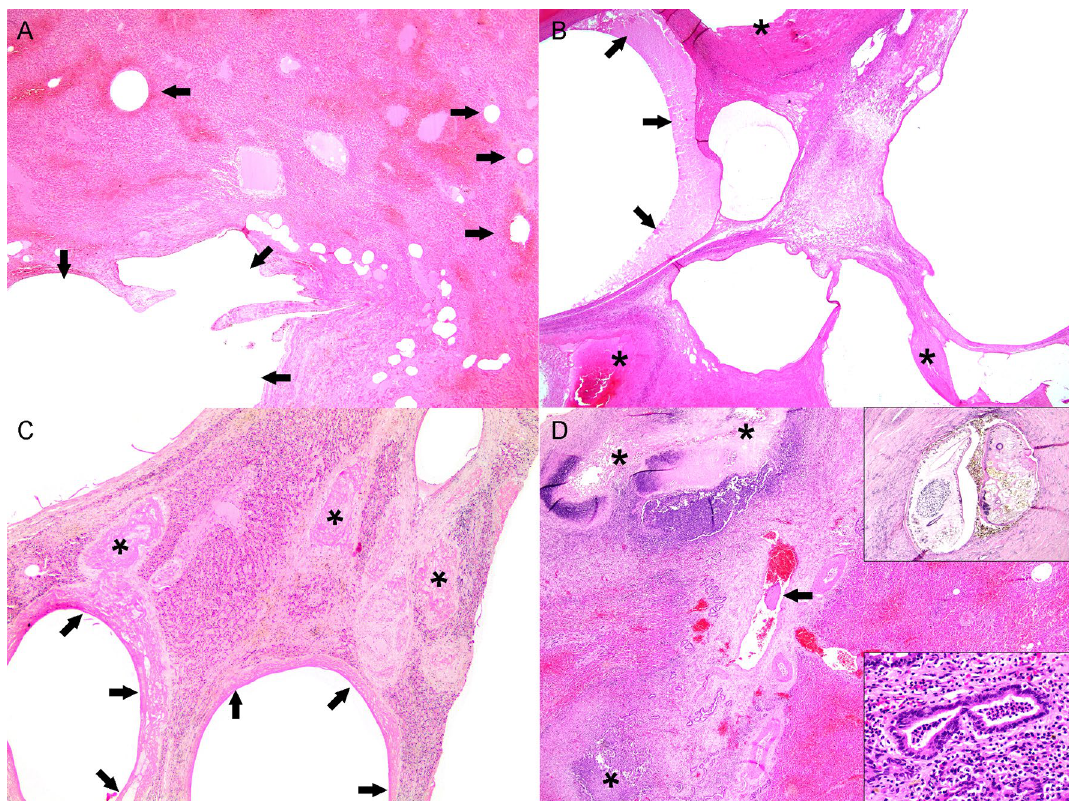
Figure 2. Microscopic features of cystic liver lesions in dolphins. ( A ) Case 4. Acute cystic lesions including cystically dilated veins of varying calibers (arrows) along with hemorrhage and sinusoidal congestion. ( B ) Case 4. Early cystic characterized by negatively-stained (empty, gas-filled) cystic dilatations with serum protein (arrows) and fibrin (asterisks). Remaining hepatic parenchyma exhibits degenerative and atrophic phenomena, as well as hepatocellular loss. ( C ) Case 3. Early to subacute venous cystic dilatations where thick peripheral fibrin (arrows) and thrombi (asterisks) prevail. The adjacent hepatic parenchyma exhibits degenerating and atrophic hepatocytes, fibrin, and mild fibrosis. ( D ) Case 3. Locally extensive pleocellular and fibrosing cholangiohepatitis with venous thrombosis (arrow) and necrosis (asterisk). Right upper inset: intralesional adult trematodes (morphology compatible with Campula sp.). Lower inset: suppurative and eosinophilic peripheralized erythrocytes, and fibrin strands. Similar cystic spaces expanded and disrupted the hepatic paren- chyma, including some cysts that were lined by few endothelial cells, and dilated sinusoids (peliosis, telangiec- tasia). Also, there was evidence of hepatocellular pressure and coagulative necrosis, and hepatocellular atrophy. Fibrin was common within the sinusoids and hepatic veins (Figs. 2 and 3). There was a clear progression from cystic spaces partially lined or circumferentially lined by fibrin (“acute”) and erythrocytes towards cystic spaces bound by variably dense bands of connective tissue (“chronic”). The latter were mostly composed of collagen, as highlighted by trichrome (Fig. 3) and Picrosirius red stains. In chronic lesions, between cysts’ walls, there were collapsed and distorted entrapped portal elements (lymphatics, blood vessels, bile ducts), as well as Kupffer cells laden with hemosiderin and/or hematoidin; the hepatic parenchyma between the cysts was congested and hepatocellular atrophy was consistent. There was no evidence of vascular recanalization in any of the cystic lesions observed yet preserved veins and arteries often exhibited varying degrees of perivascular intimal and mural fibroelastosis, arteriosclerosis and tunica media hypertrophy and hyperplasia. Neovascularization and hepatocellular nodular hyperplasia were not apparent. All these animals had localized to multifocal, moderate to severe trematodal cholangiohepatitis with necrosis (Fig. 2D), bile duct hyperplasia, fibrosis, hemorrhage, and hemosiderosis. Cases 1 and 2 had concomitant hepatic intralesional bacteria. Case 3 also had marked cholestasis. Other relevant histopathologic findings in these animals were as follows. Case 1 had necroulcerative and suppurative gastritis with P. gastrophilus eggs and bacteria (pyloric chamber); chronic pancreatic ductitis/peri- ductitis with fibrosis and intralesional trematode adults and eggs; pulmonary nematodiasis; mesangiocapillary glomerulopathy with tubular proteinosis; focal lymphocytic perivascular cuffing in cerebrum and Nasitrema sp. eggs associated with cranial nerves, as well as encephalic hemorrhage, edema and perivascular astrocytosis; and left pyogranulomatous orchitis with bacteria, thrombosis and fibrosis. Case 2 had necroulcerative and suppurative gastritis with perforation, fistula, and P. gastrophilus eggs and bacteria; peritonitis; and splenic and skeletal muscle intravascular bacteria. Case 3 had necroulcerative and suppurative gastritis with perforation and P. gastrophilus eggs and bacteria; severe pulmonary edema; granulomatous prostatitis; and minimal, focal lymphoplasmacytic